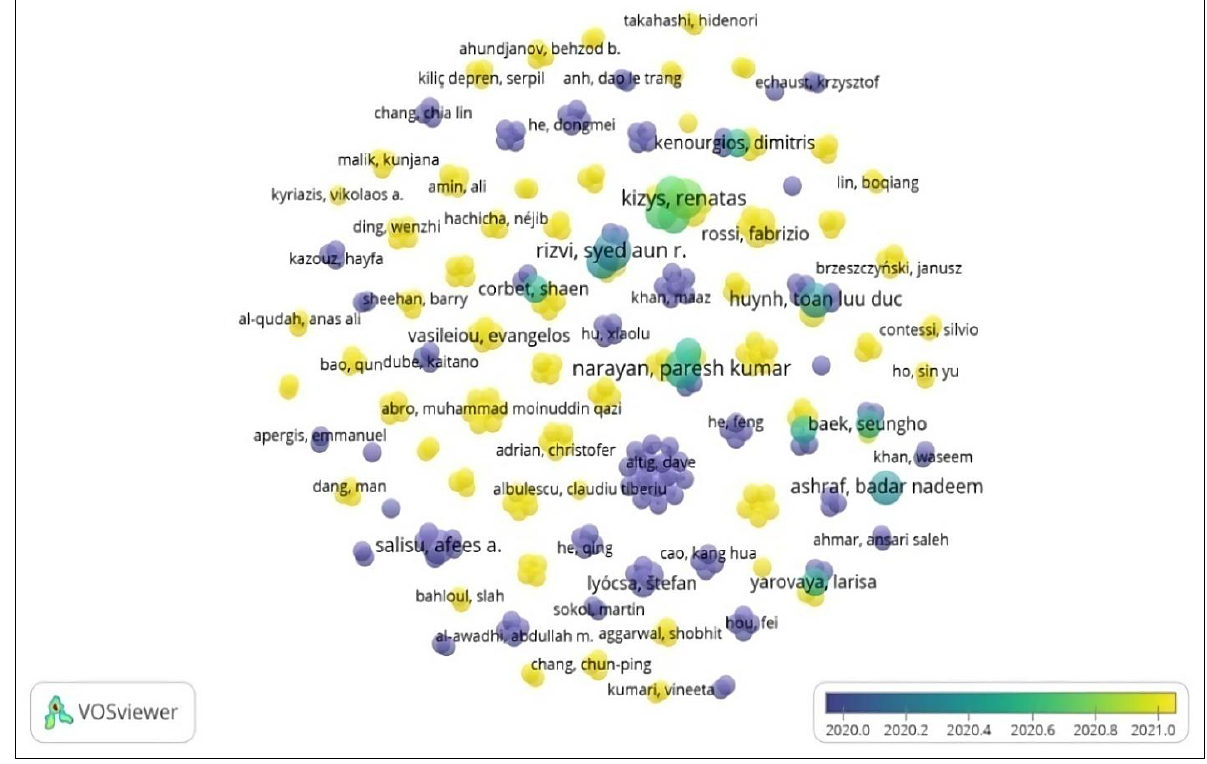
Figure 3. Overlay Visualization (All Authors)